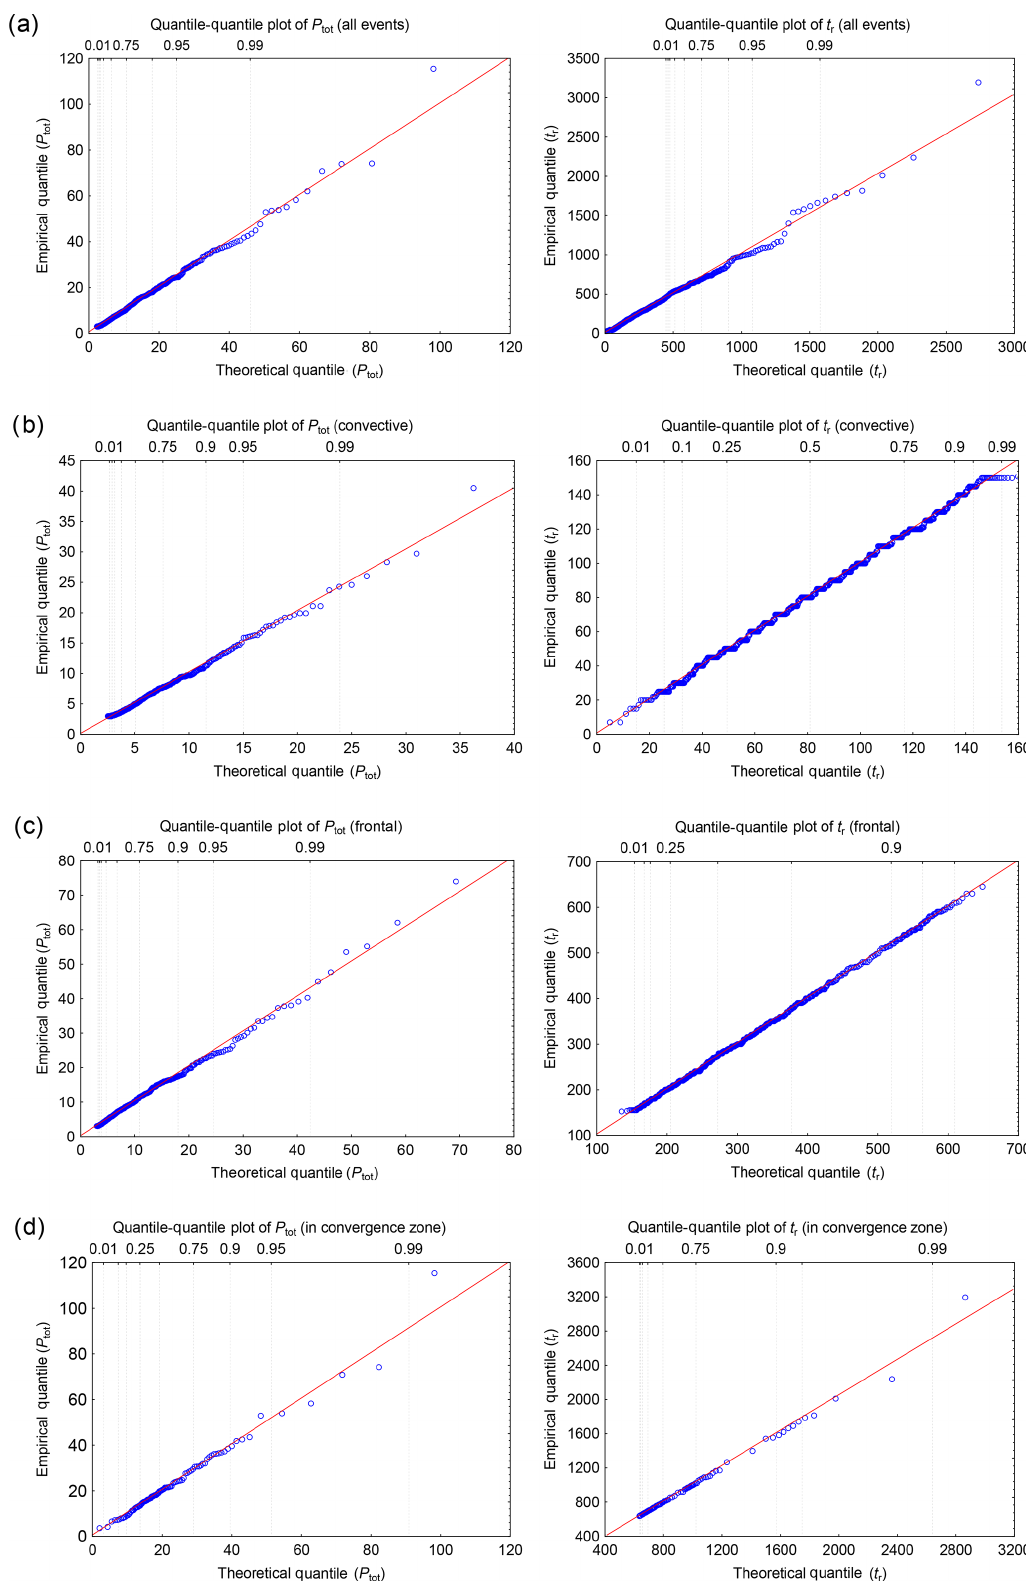
Figure 7. Comparison of empirical and theoretical quantiles concerning P tot and t r values for (a) all events, (b) convective, (c) frontal, and (d) rainfall in the convergence